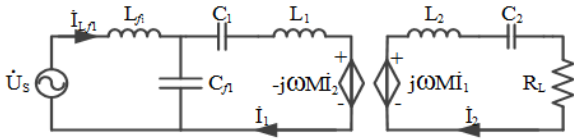
Figure 1. Inductively coupled power transmission system with LCC / S compensation topology.